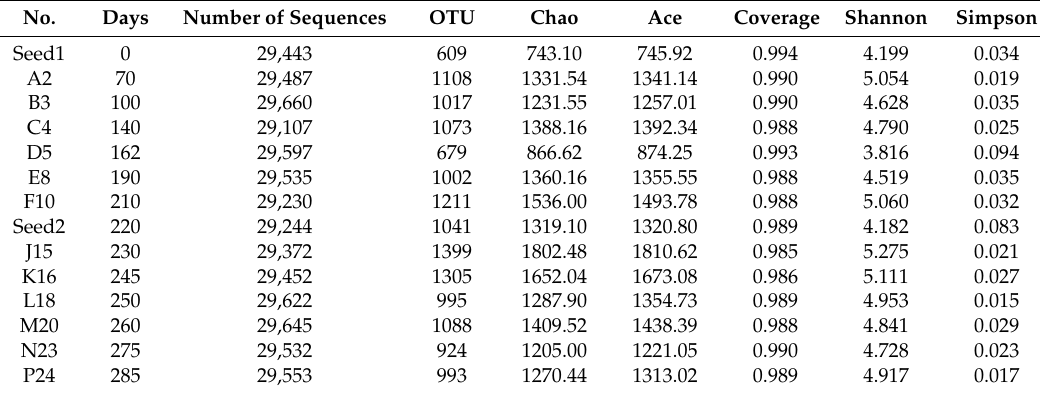
Table 3. Diversity and Richness indices of microbial communities for the AnMBR samples. No. Days Number of Sequences OTU Ace Coverage